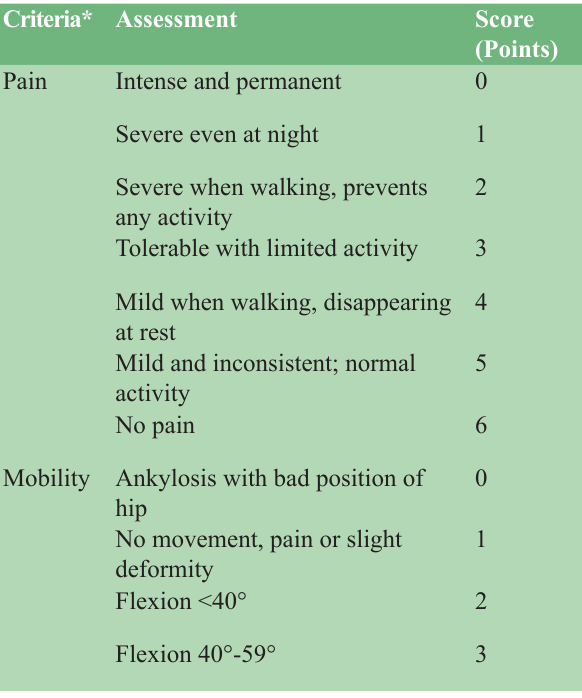
Table 1: The Merle d’Aubigné Hip Score 7 Criteria*